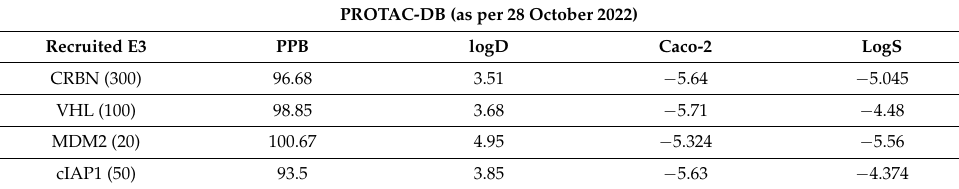
Table 2. Predicted plasma protein binding, permeability comparison among a set of published